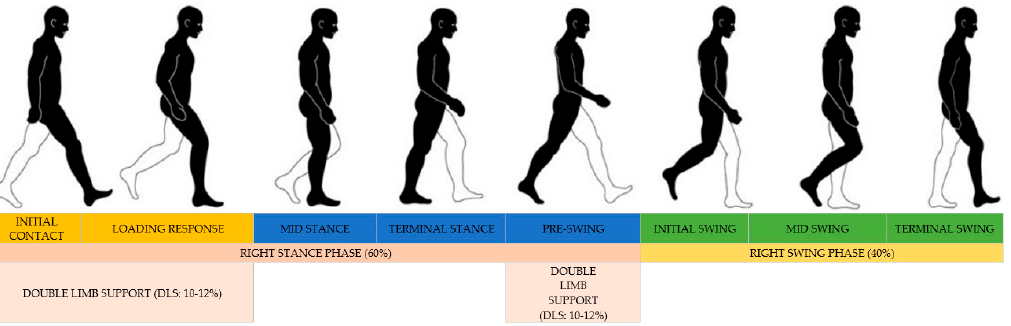
Figure 1. Example of a typical gait cycle (emphasis right leg) with phases, percentages, and func- tional periods.